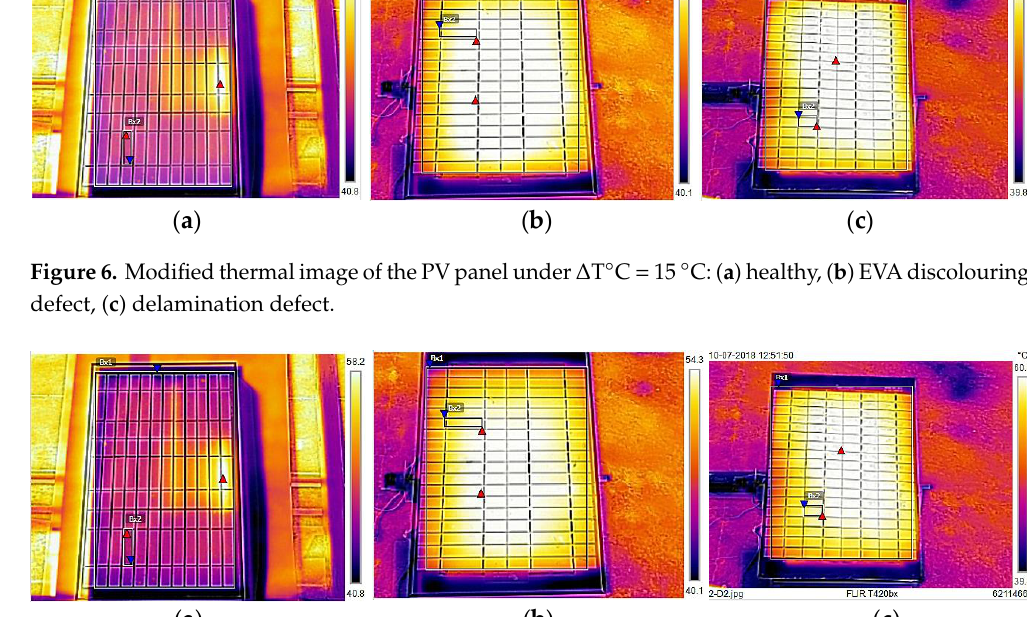
Figure 7. Modif ied thermal image of the PV panel under ΔT°C = 20°C : ( a ) healthy, ( b ) EVA Figure 7. Modified thermal image of the PV panel under ∆ T ◦ C = 20 ◦ C: ( a ) healthy, ( b ) EVA discolouring discolouring defect, ( c ) delamination defect. defect, ( c ) delamination defect. Table 7. Comparative analysis of defected panels with the healthy Table 7. Comparative analysis of defected panels with the healthy panel.